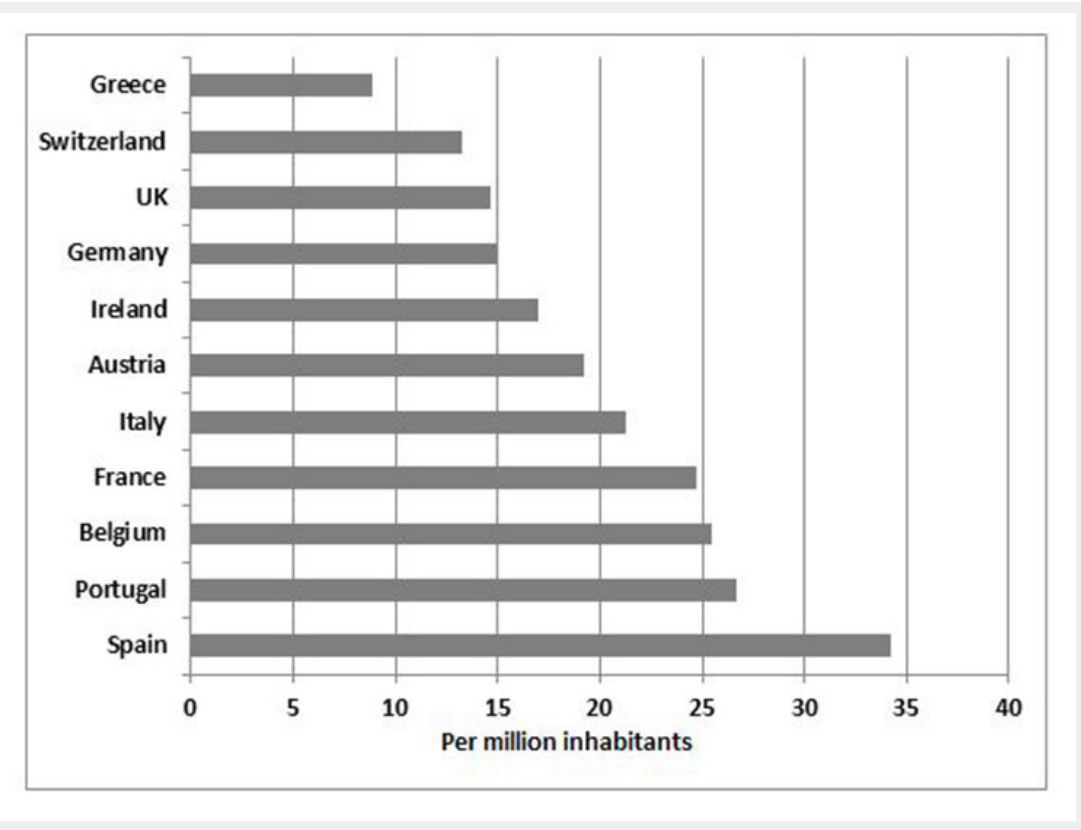
Figure 7 Number of deceased organ donors per million inhabitants in Europe 2009 (adapted from [47]: Van Gelder F, Manyalich1 M, Nanni Costa A, Paez G. 2009 International donation and transplantation activity. IRODaT preliminary data. Organs, Tissues and Cells 2010;13:5‒8. With kind permission from Editrice Compositori, Bologna,